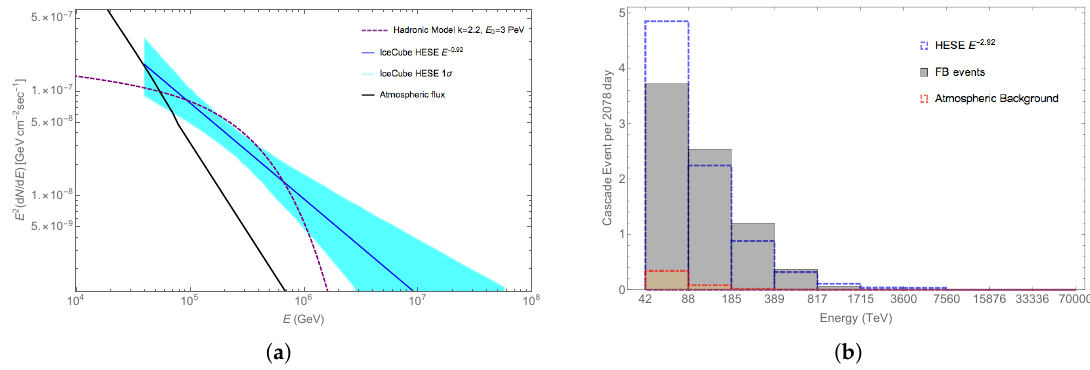
Figure 3. ( a ) Neutrino fluxes. Best-fit astrophysical neutrino fluxes with a single power law of E − 0.92 and one sigma uncertainties as represented by the blue shading. The black line represents the atmospheric neutrino fluxes, and the magenta line is the hadronic flux in Figure 2. ( b ) Neutrino event rate. The expected number of neutrino events from the FB as well as the astrophysical and atmospheric backgrounds are represented by gray bars as well as red and white (dashed blue edge) bars,